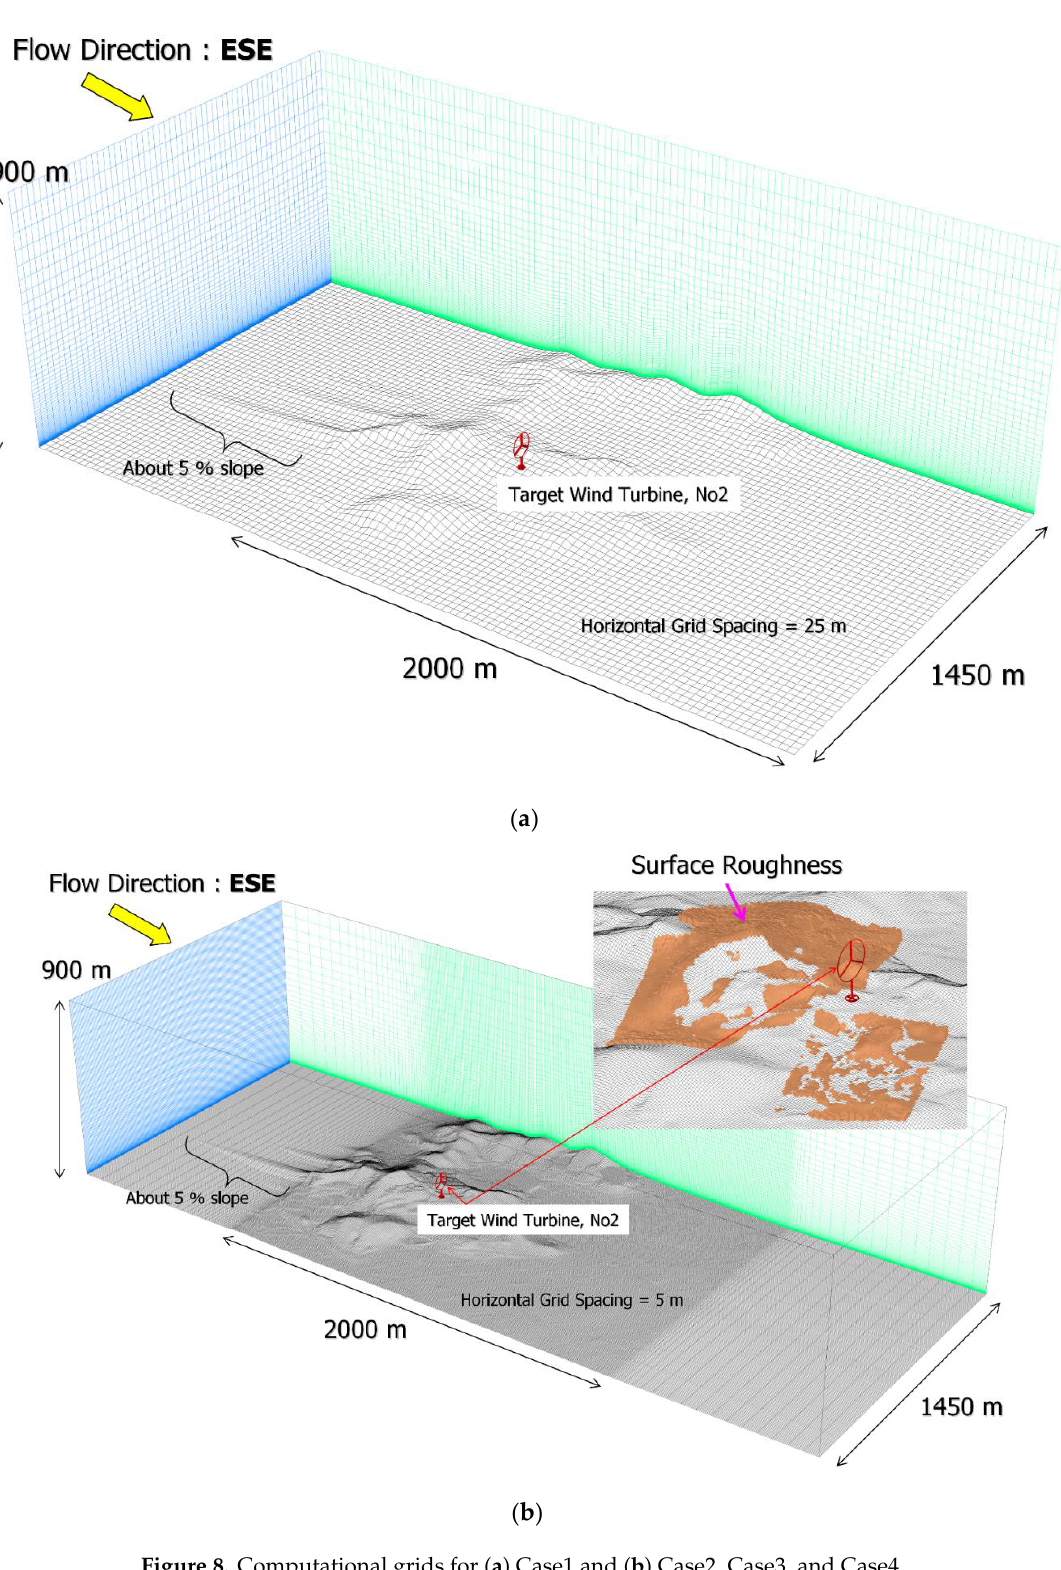
Figure 9. Vertical grids for Case3 and Case4 near the ground. Concerning the boundary conditions, the power law distribution following N = 7, shown in Figure 10, was assigned to inflow conditions. In this research, to discuss the effects of terrain-induced turbulence originating from the ups and downs of the terrain, the inflow turbulence was omitted. Here, z * (m) of the vertical axis shows the height (m) from the surface of the terrain. The lateral interfaces and upper interface were assigned a slip condition and the outflow interface was assigned a convection-type outflow condition. A no-slip condition was assigned to the surface of the terrain. The non-dimensional parameter Re in Equation (2) is a Reynolds number (= U in h / ν ) and Re = 10 4 . The handling of representative scales is shown in Figure 11, where h represents the difference in elevation (120 m) within the calculation area, U in denotes the wind speed at the highest latitude position of the inflow boundary interface, and ν is the coefficient of kinematic viscosity. The time step was set to Δ t = 2 × 10 – 3 h/U in . As previously explained, the numerical simulation in this research targeted the east-southeast wind for calculation.